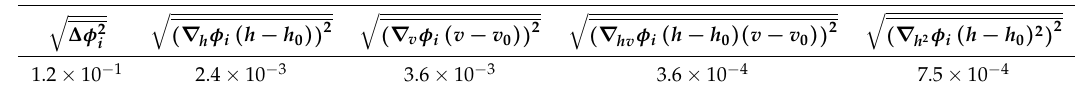
Figure 12. Quantitative results derivable from the inhomogeneities in the phase stepping deviations ∆ φ ( j ) (Equation (19)). On the left, the change in tilt angle about the optical axis from frame to i frame within the phase stepping series is shown along with the accompanying linear motion error. Rotation correlated translations indicate an off-center pivot point. On the right hand side, the relative grating scaling error is shown along with the found tilt and slant about the horizontal and vertical axis. These quantities represent deviations from the mean grating alignment throughout the phase stepping series. The tilt and slant angles range close to the expected noise level (cf. Table 1 and Equation (27)). Table 1. Root mean square contributions of the mean, gradient and curvature components of ∆ φ i ( j ) to the sampling phase deviations found for the present phase stepping series in units of radians. The homogeneous error ∆ φ i is by far the dominating effect. The contributions of ∇ hv φ i and ∇ h 2 φ i range in the order of magnitude of the expected noise level of 10 − 4 rad (cf. Equations (26) and